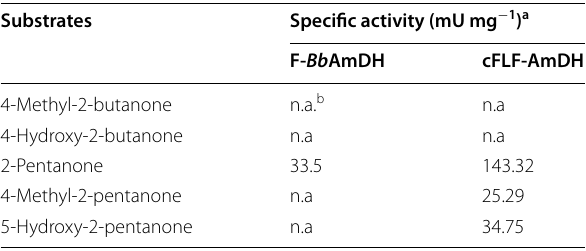
Table 3 Specific activity (mU mg − 1 ) of F- Bb AmDH and cFLF- AmDH toward aliphatic ketones